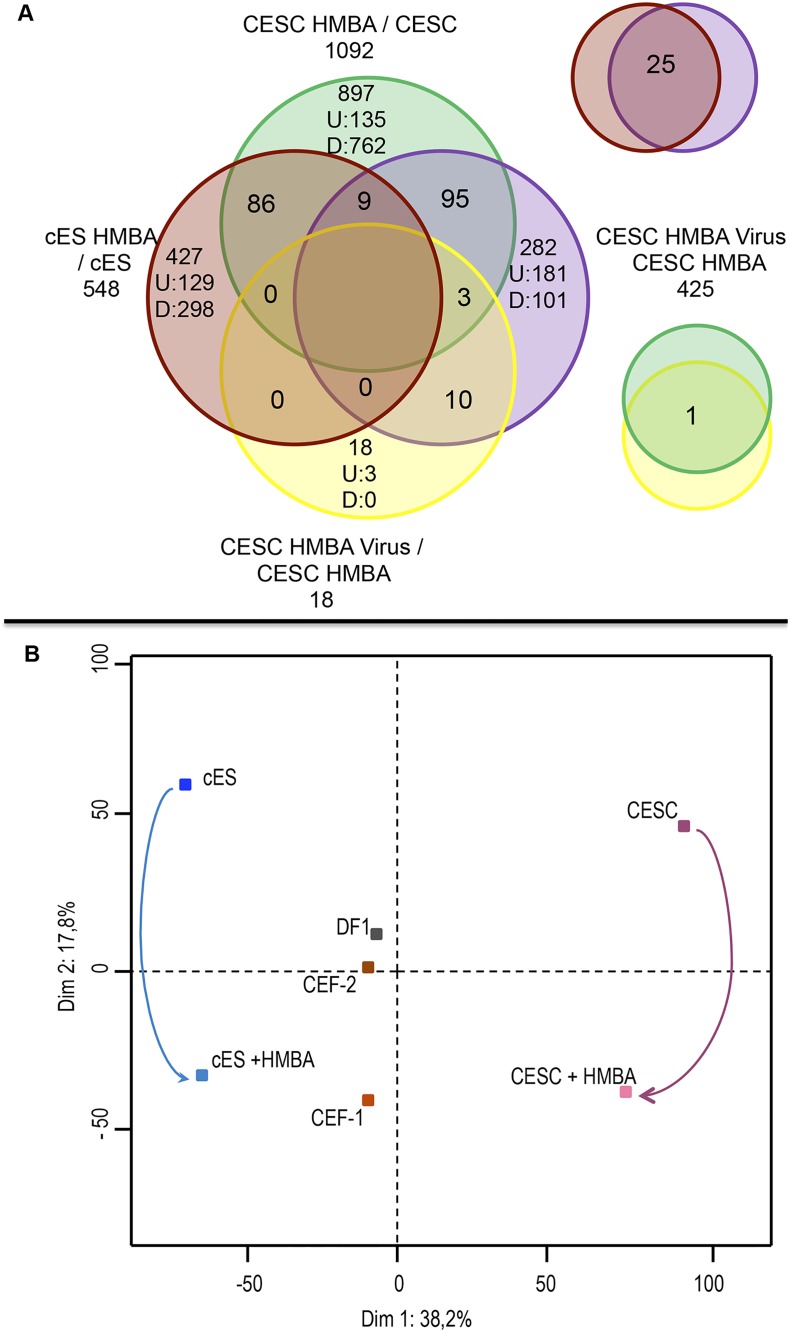
The HMBA treatment modifies the transcriptomic profile of both CESCs and cES cells.(A) The Venn diagram illustrates the genes that are differentially expressed between CESC and cES cells treated with or without HMBA and uninfected or infected with vBAC20UL49GFP inoculums. (B) A PCA analysis was performed on the common genes identified from this study and those provided by the datasets GSE61221 for the CEF-1, GSE38168 for the CEF-2 and GSE47191 for the DF1 cells.